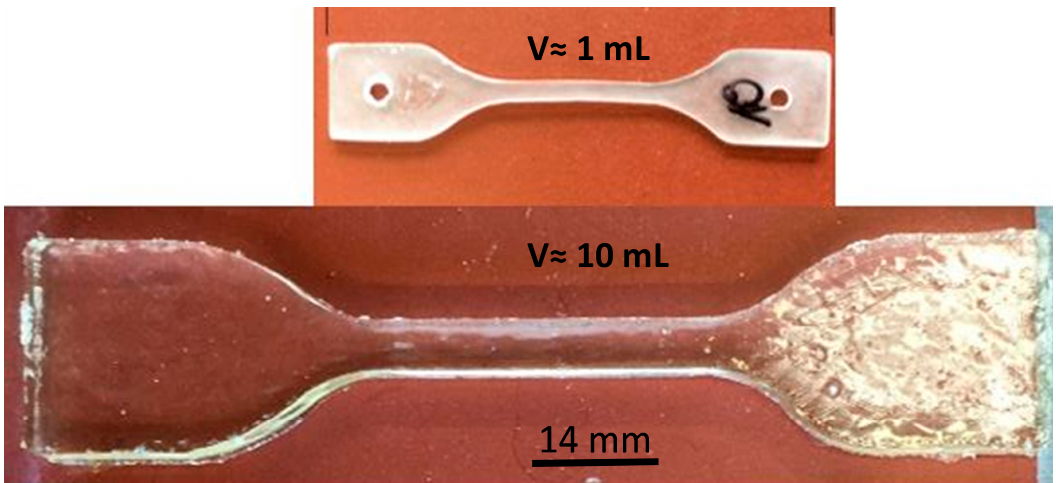
Figure A2. Results of the rheology and DMTA measurement of the urea-crosslinked copolymer network.